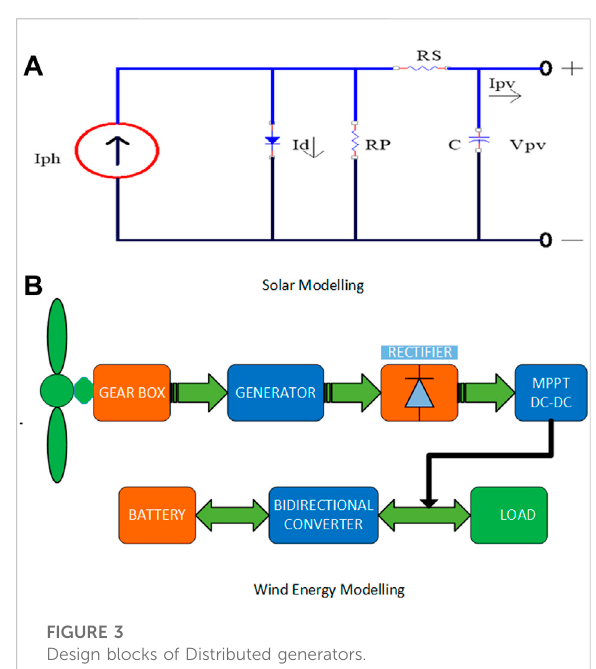
FIGURE 3 Design blocks of Distributed